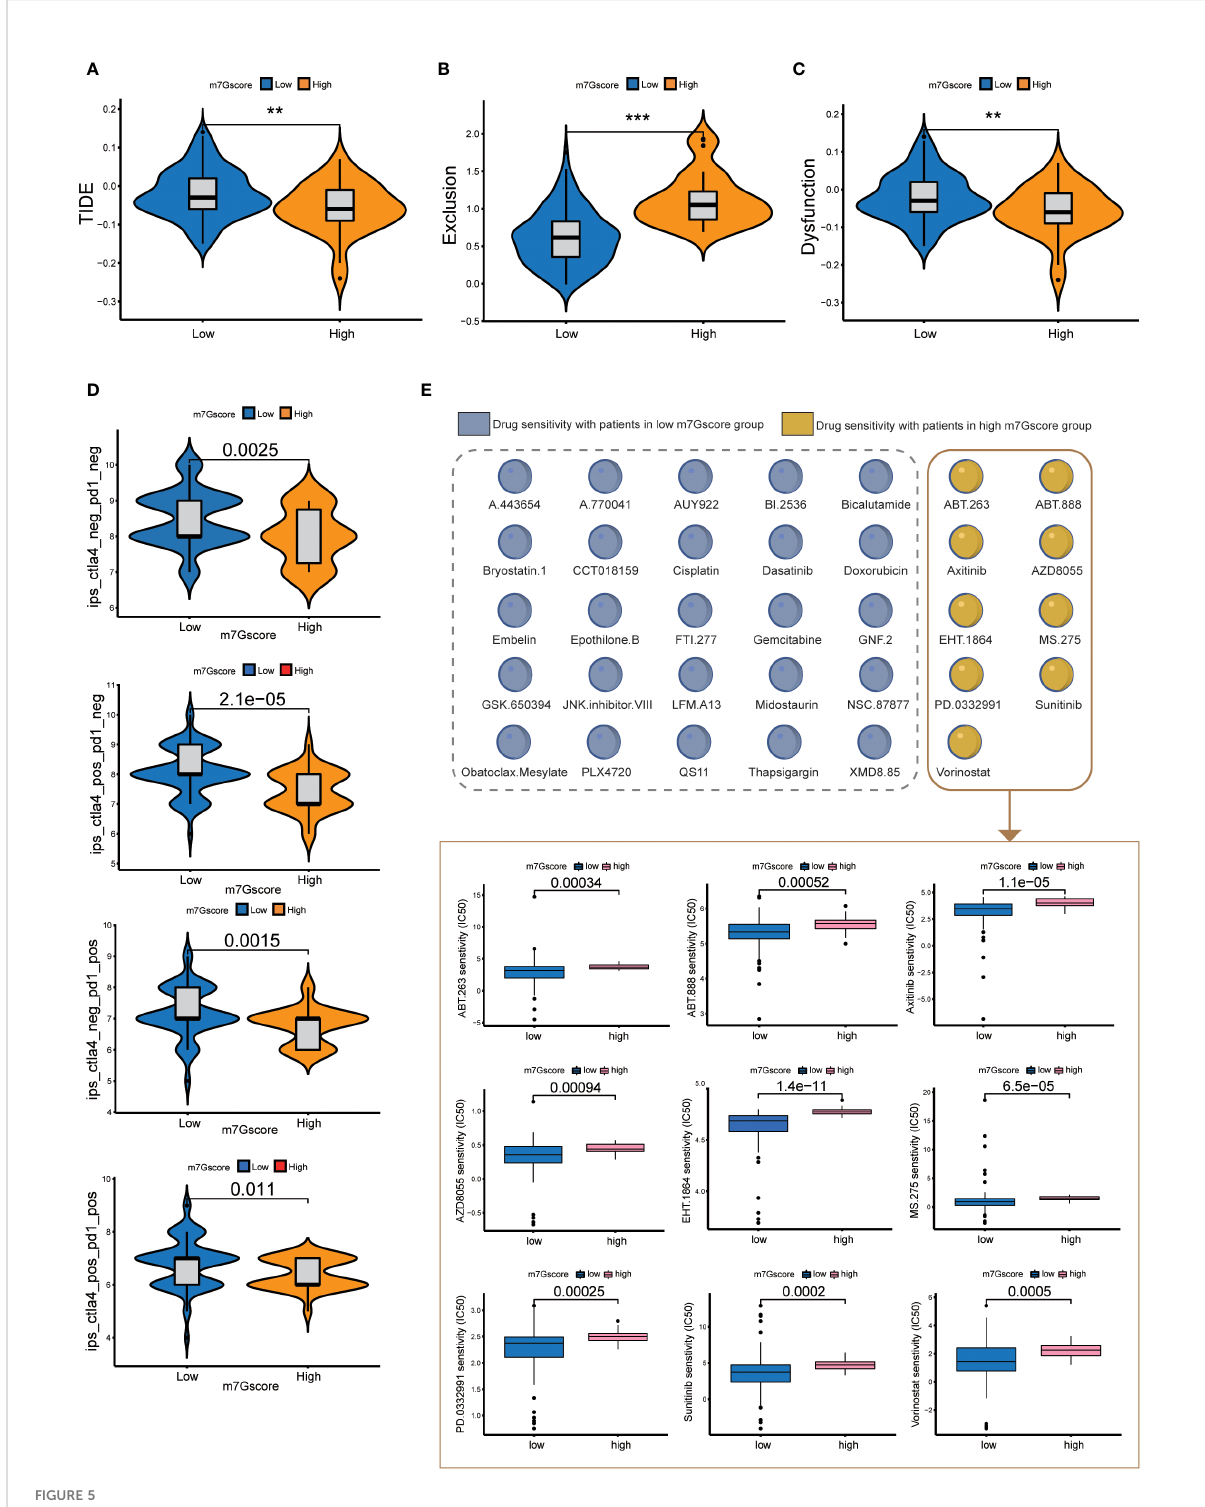
FIGURE 5 Immune checkpoint treatment and drug sensitivity. (A – C) TIDE score, Exclusion score and Dysfunction score of high and low m7G score groups. **p<0.01; ***p<0.001 (D) Immune checkpoint treatment in the high and low m7G score groups. (E) Drug sensitivity in the high and low m7G score